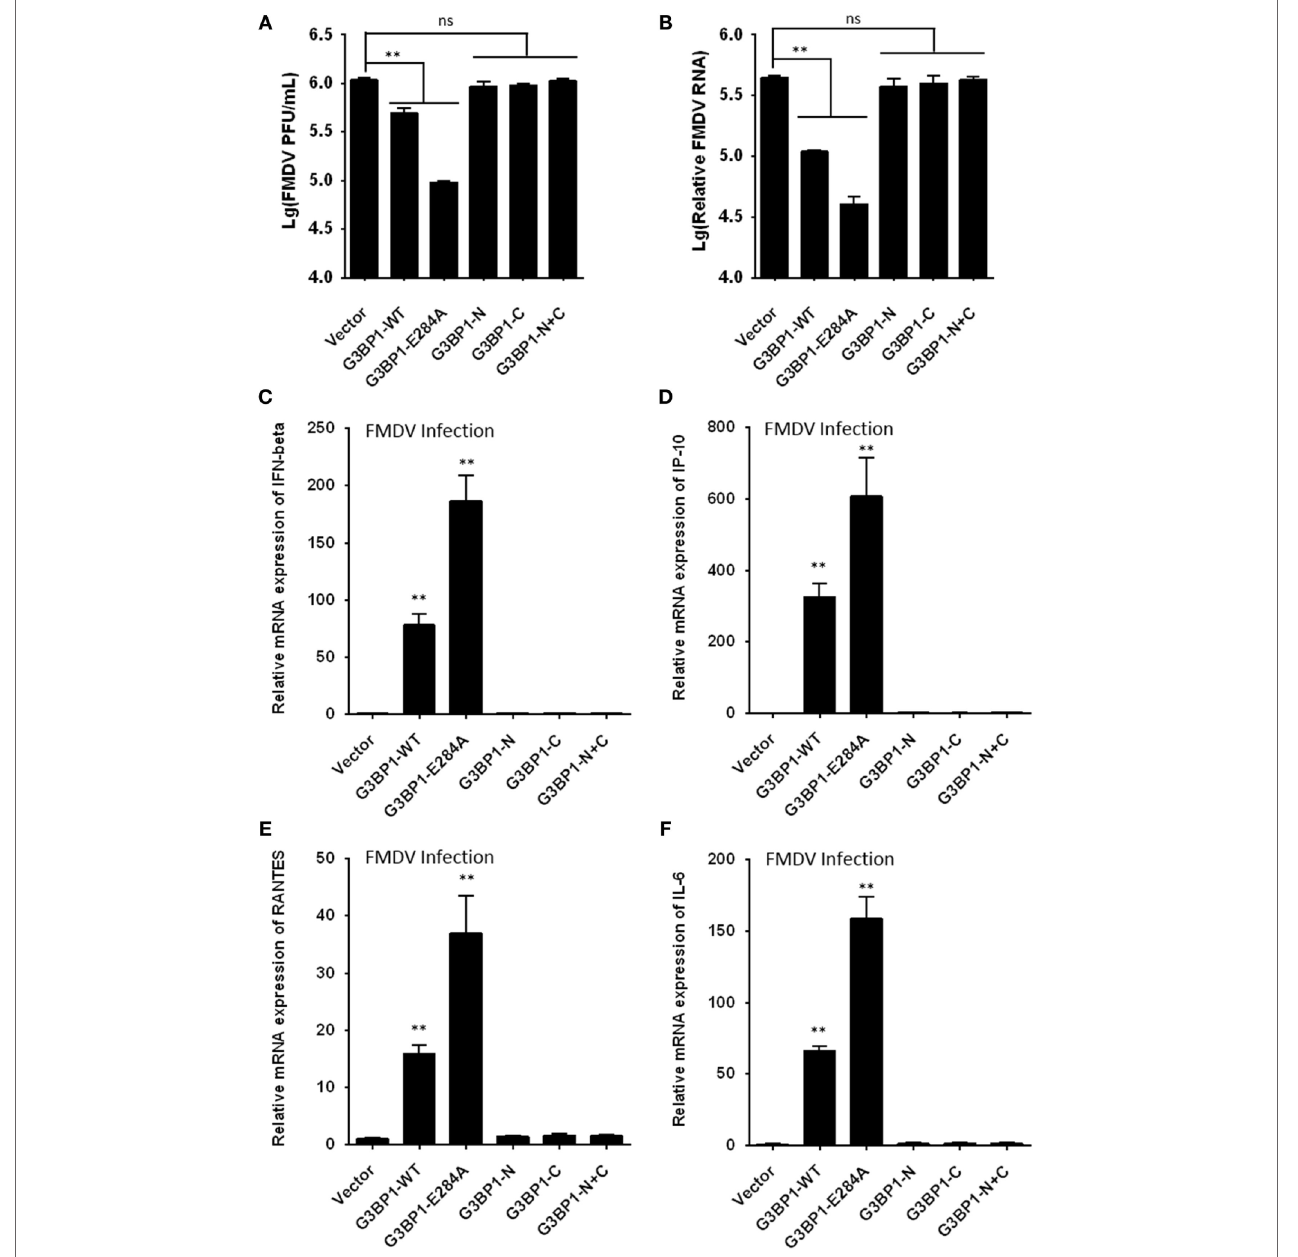
FigUre 8 | G3BP1 inhibits foot-and-mouth disease virus (FMDV) replication and induces interferon (IFN) and other cytokines expression in FMDV-infected cells. (a,B) IBRS-2 cells were transfected with the designated Flag-tagged porcine G3BP1 expression plasmids or an empty vector, and, 30 h later, the cells were infected with FMDV (MOI = 5). 6 h after FMDV infection, virus plaque (a) and real-time PCR (B) were performed to analyze for virus titer and genome RNA. (c–F) IBRS-2 cells were transfected with plasmid encoding Flag-tagged wild-type porcine G3BP1 or its mutants as indicated, and, 30 h later, the cells were infected with FMDV (MOI = 5). 6 h after FMDV infection, total RNA was extracted and the expression of IFN-beta (c) , IP-10 (D) , RANTES (e) , IL-6 (F) , and glyceraldehyde-3-phosphate dehydrogenase genes were evaluated by quantitative real-time reverse